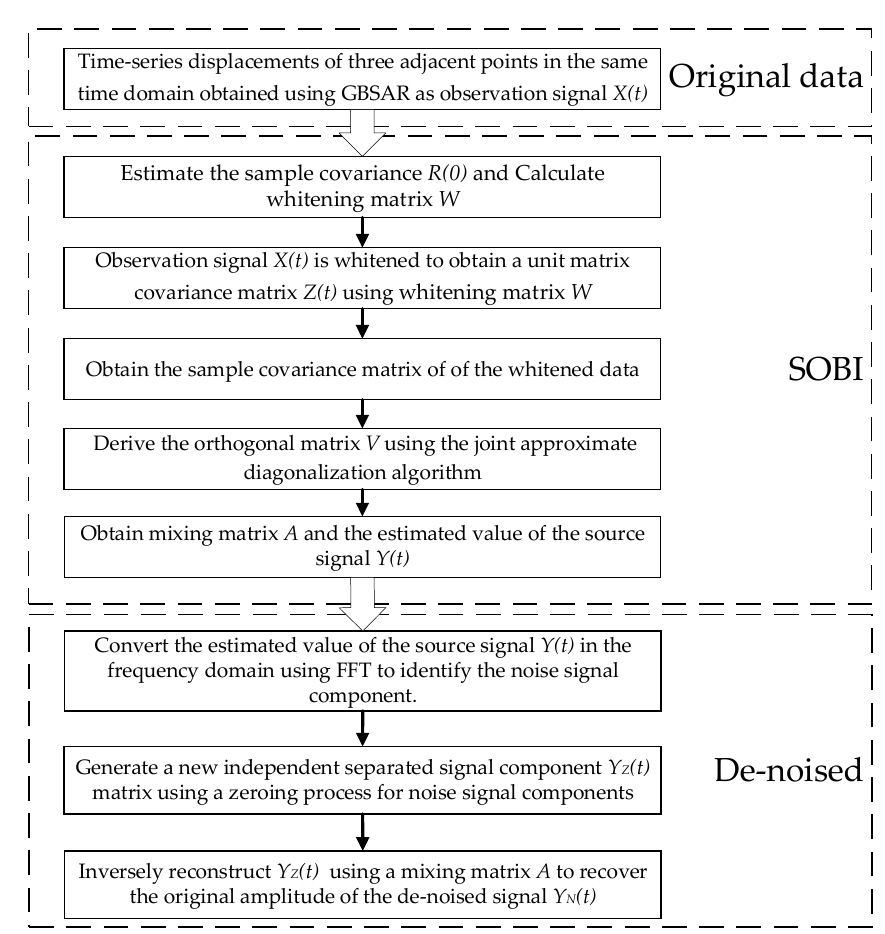
Figure 2. Flowchart of the improved second-order blind identification (SOBI) signal de-noising method for the obtained time-series displacement of bridges using ground-based synthetic aperture radar (GBSAR).